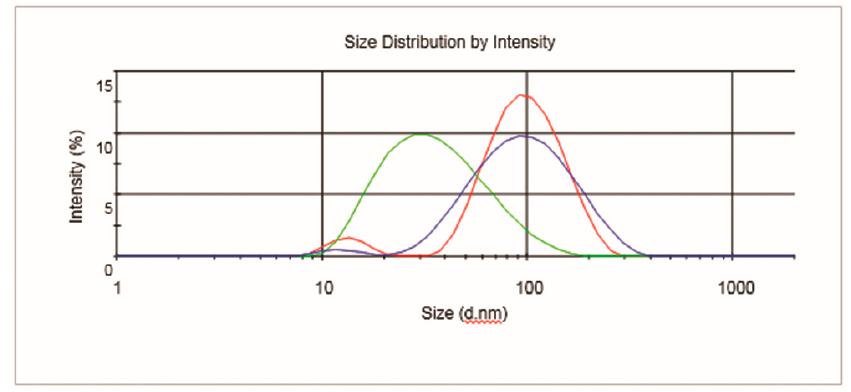
Figure 12. Dynamic light scattering ( DLS) profiles of SPION1 ( green ), SPION2 ( red ), and SPION3 ( blue ).